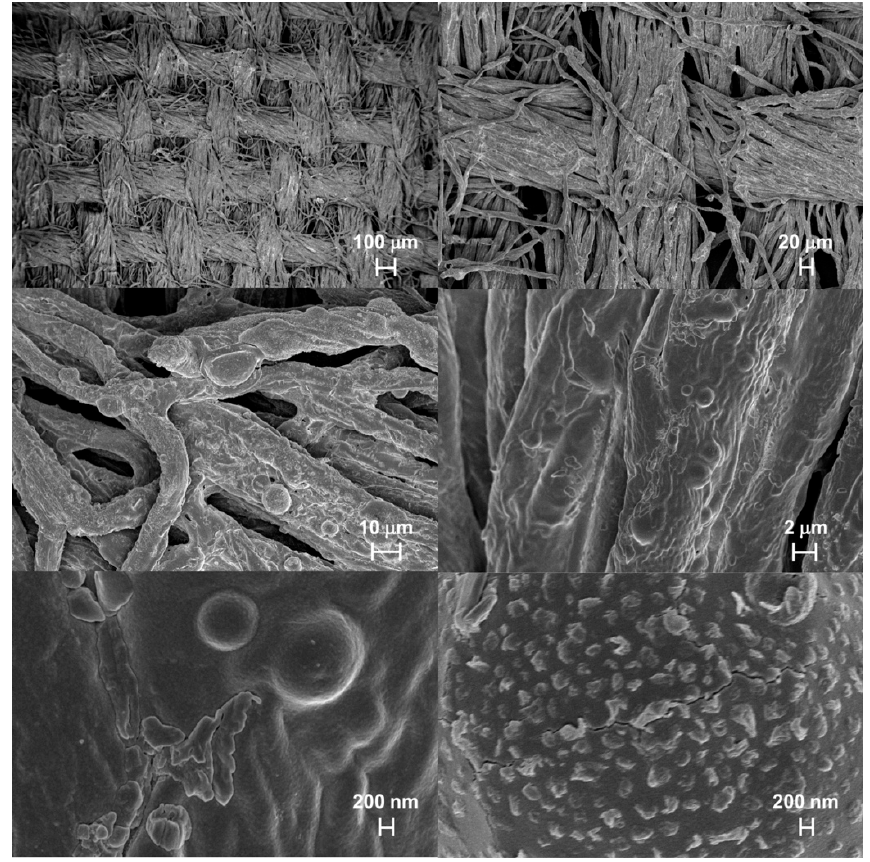
Figure 12. FE-SEM micrographs of COT/M–G 50 –C 50 residue after horizontal flame spread tests.